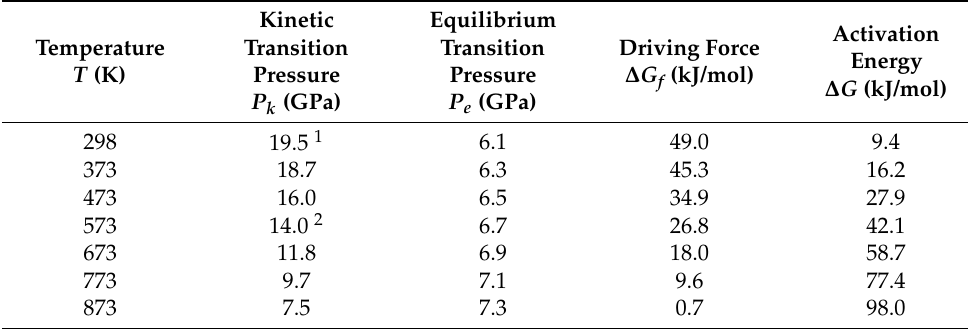
Table 3. The values of ∆ G f and ∆ G